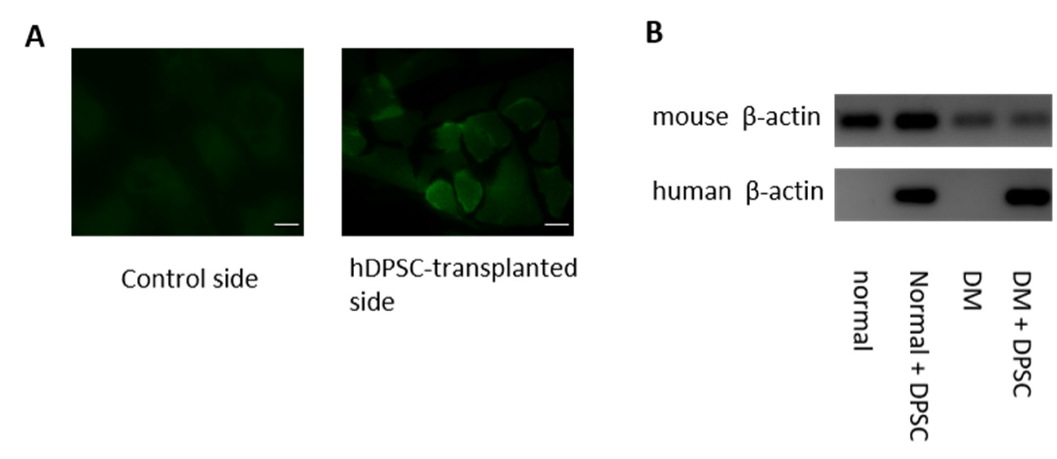
Figure 7. Location of transplanted hDPSCs in the gastrocnemius muscles. ( A ) Sixteen weeks after hDPSC transplantation in the hindlimb skeletal muscles, the transplanted cells were stained with anti-human nuclei antibody. Bar = 25 µm. ( B ) The human β -actin mRNA expression was evaluated by real-time quantitative polymerase chain reaction. The products were visualized by agarose gel electrophoresis with ethidium bromide staining. DM: diabetes